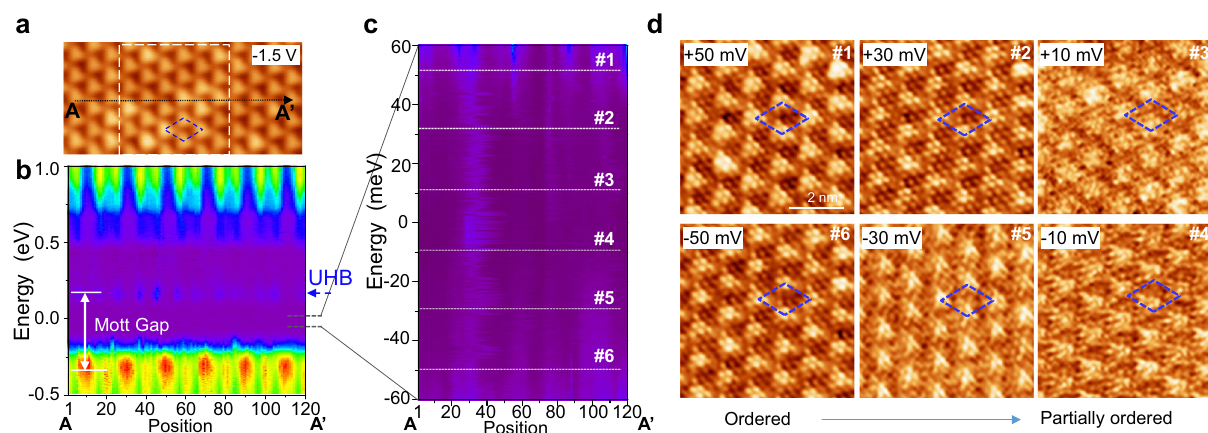
Fig. 4 Resolving CDW pattern in Mott insulator gap. a Area of 1T-NbSe 2 ; AA ′ is the line along which line d I /d V spectra were obtained. b Line d I /d V spectra captured along six CDW periods (AA ′ in a ) showing Mott gap between UHB and LHB. c Zoomed-in line d I /d V spectra in b , showing residual conductance within the gap, lacking periodicity. d Bias-dependent images showing CDW pattern clearly in Mott insulator gap. Energy positions are labeled in c , tunneling parameters: a − 1.5V, 10pA; b − 1.5V, 1nA; c − 0.1V, 0.5nA before turning off Fig. 5, in which the atomic lattice in the center of the fl ower was resolved more effectively. The √ 3 × √ 3 R30° superstructure of the fl ower pattern can be well distinguished in the FFT pattern, as shown in Fig. 3f. Two sets of reciprocal lattices were resolved: the blue basis vectors represent the CDW lattice, and the black ones represent the √ 3 × √ 3 R30° with respect to the CDW pattern. Additional data of the √ 3 × √ 3 R30° superstructure were observed from a direct comparison of the STM images at − 1.5 and + 0.2 V, as shown in Supplementary Figs. 6, 7 and 8.